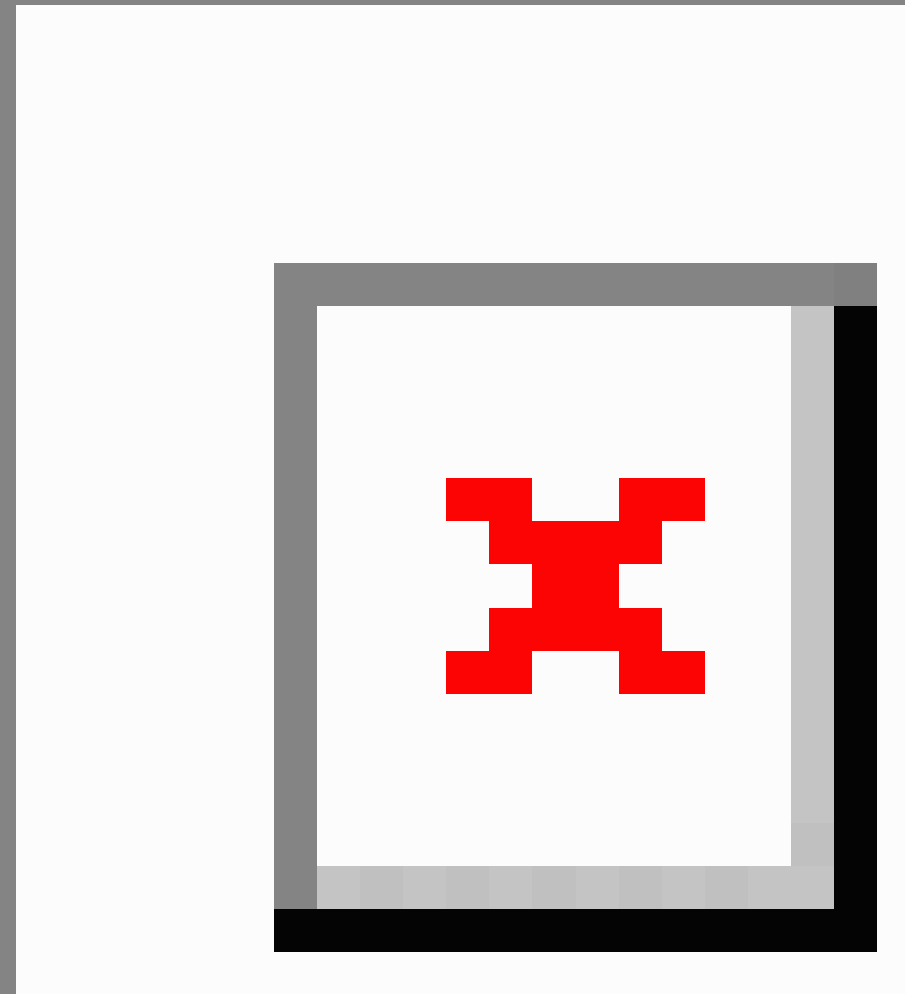
Figure 2. Screenshot of the story topics group search